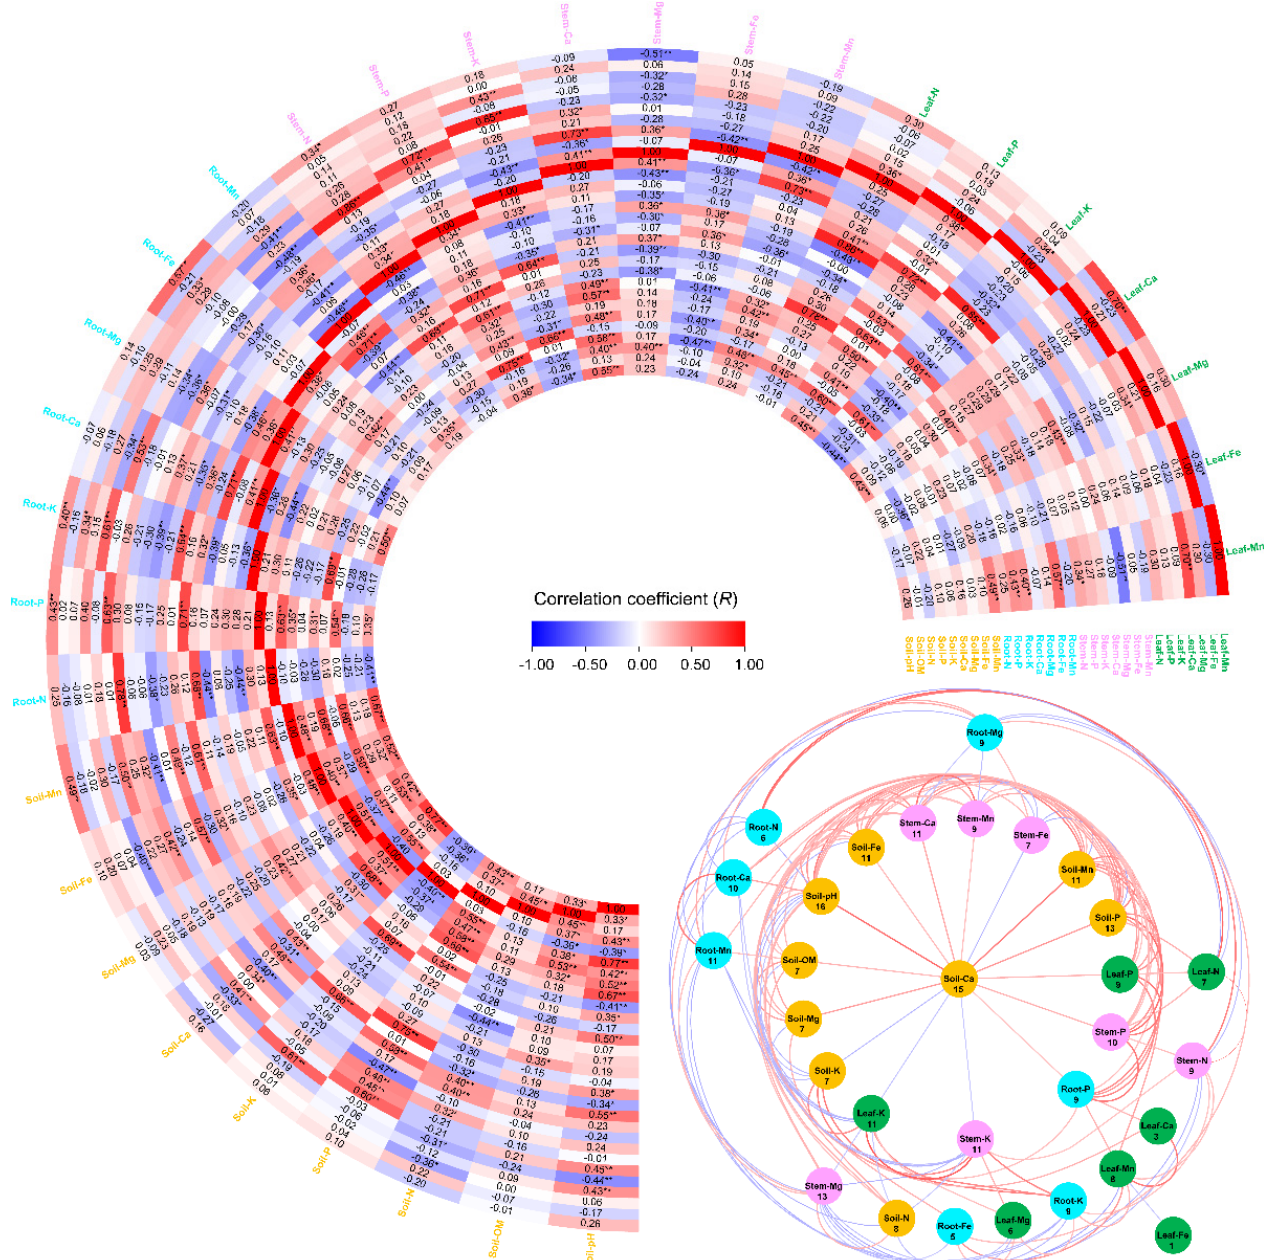
Figure 4. Plant–soil nutrient relationships of golden Camellia species. The heat map shows the correlation coefficients between 30 indices of soil and plants. * and ** indicate significant correlation coefficients at the p = 0.05 and p = 0.01 levels. Networks were constructed by extracting significant correlation coefficients from the heat map ( p < 0.05). The circles indicate indices, their colors corre ‐ spond to the indexes on the heat map, and the values underneath each index indicate the number of connected nodes. The color of the lines between the circles represents the correlation coefficient.